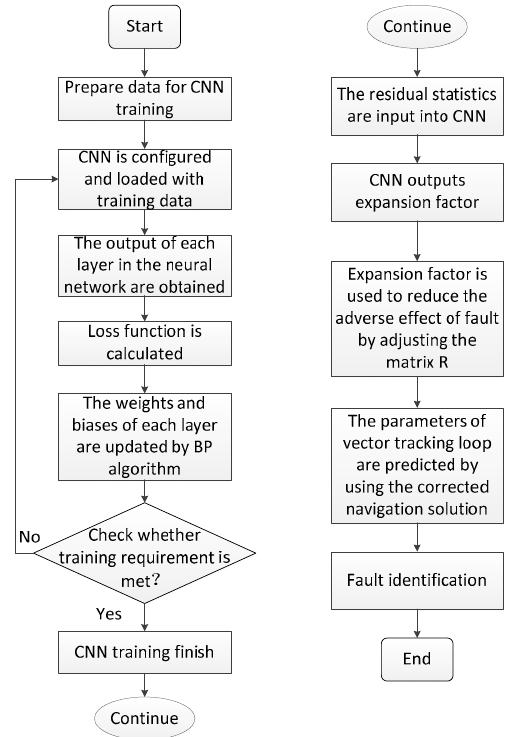
Figure 5. Flowchart of the proposed method.